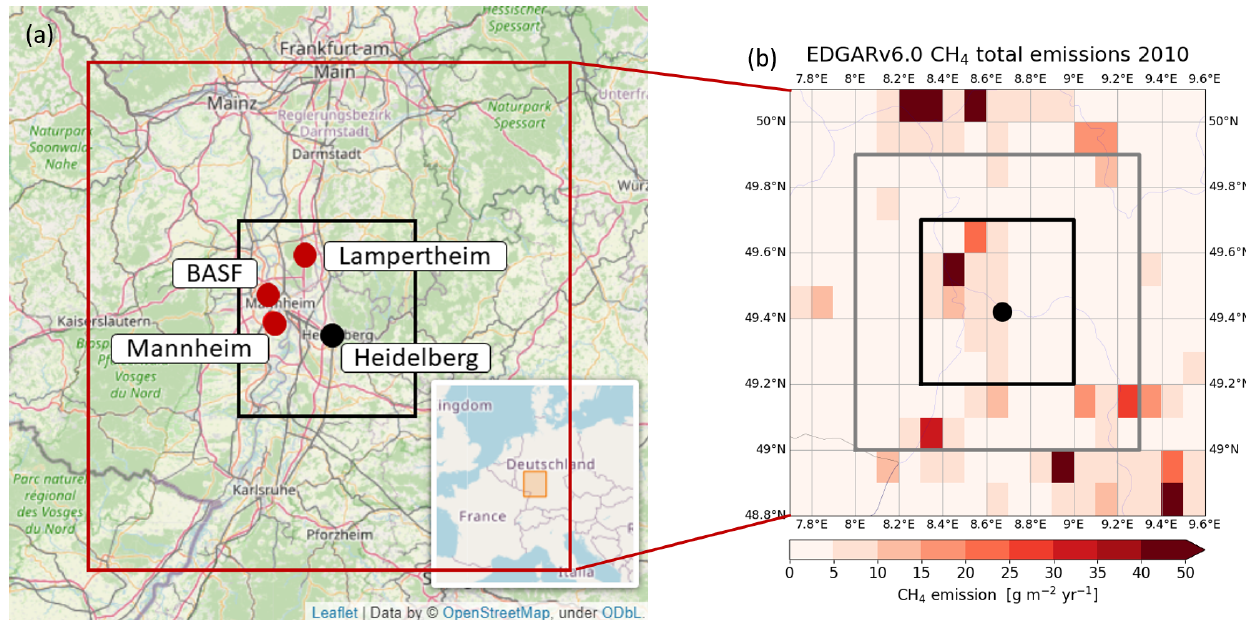
Figure 1. (a) Map of the upper Rhine valley south of Frankfurt/Main with the location of Heidelberg (black dot). The red dots indicate industrial areas (Mannheim/Ludwigshafen with the BASF chemical factory) and locations of large solid waste deposits (Lampertheim, Mannheim) in the small influence area of the station (© OpenStreetMap contributors; distributed under the Open Data Commons Open Database License – ODbL – v1.0). (b) Gridded CH 4 emissions as reported by the EDGARv6.0 inventory for 2010 (Crippa et al., 2021) covering a ca. 150km × 150km (“large”) area surrounding Heidelberg. Two smaller areas, the so-called “small” (ca. 70km × 70km) and “intermediate” (ca. 110km × 110km) influence areas of Heidelberg, are marked as a black and grey rectangle, respectively. Long-term trends of average CH 4 emissions from the three influence areas are displayed in Fig.